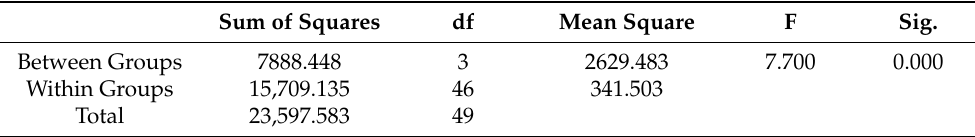
Table 3. ANOVA test of means with relation to landscape